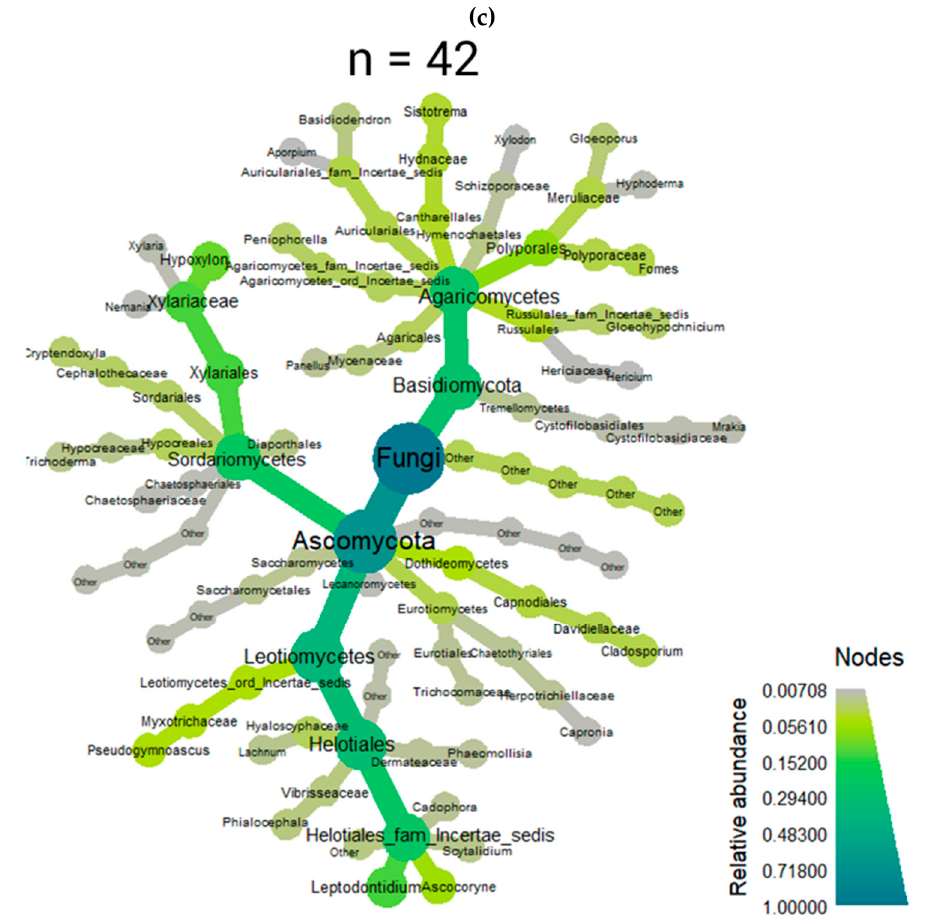
Figure 5. Distribution of the fungal diversity and relative abundance of fungi in wood from ( a ) live trees; ( b ) dead trees; ( c ) trees with advanced rot.